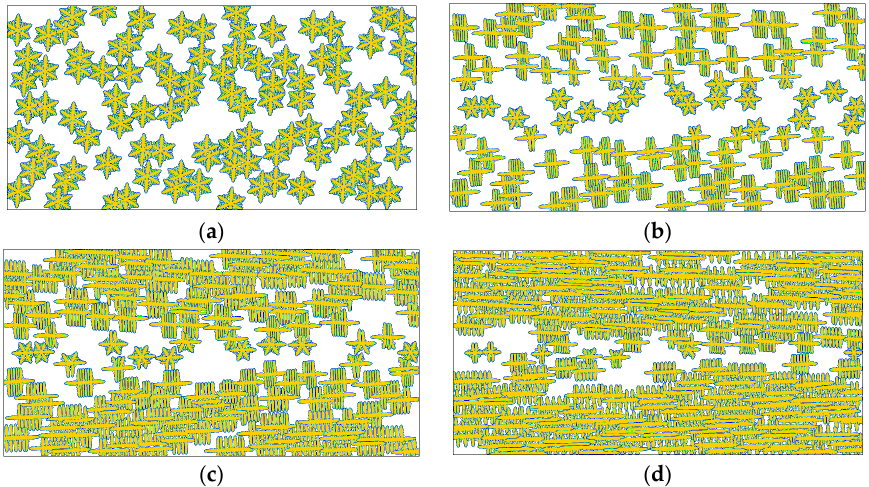
Figure 7. Simulated crystallization morphologies in the crystal order parameter field for different flow strength at anisotropy strength ε = 0.03: ( a ) ˆ γ “ 1.0, t “ 1000; ( b ) ˆ γ “ 10, t “ 800; ( c ) ˆ γ “ 30, t “ 800; ( d ) ˆ γ “ 100, t “ 600. Here the time instants are chosen to ensure the results show similar sizes of crystallized regions.